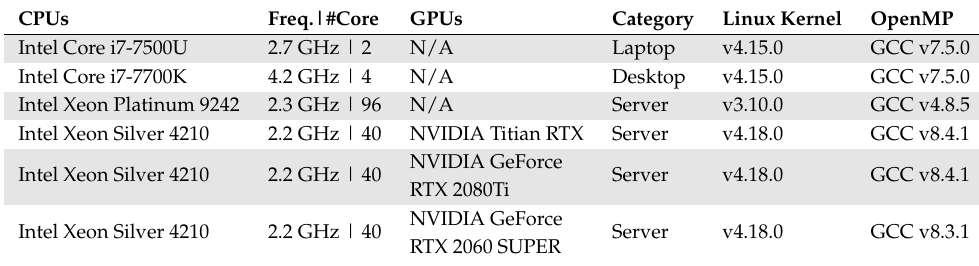
Table 2. The hardware and system